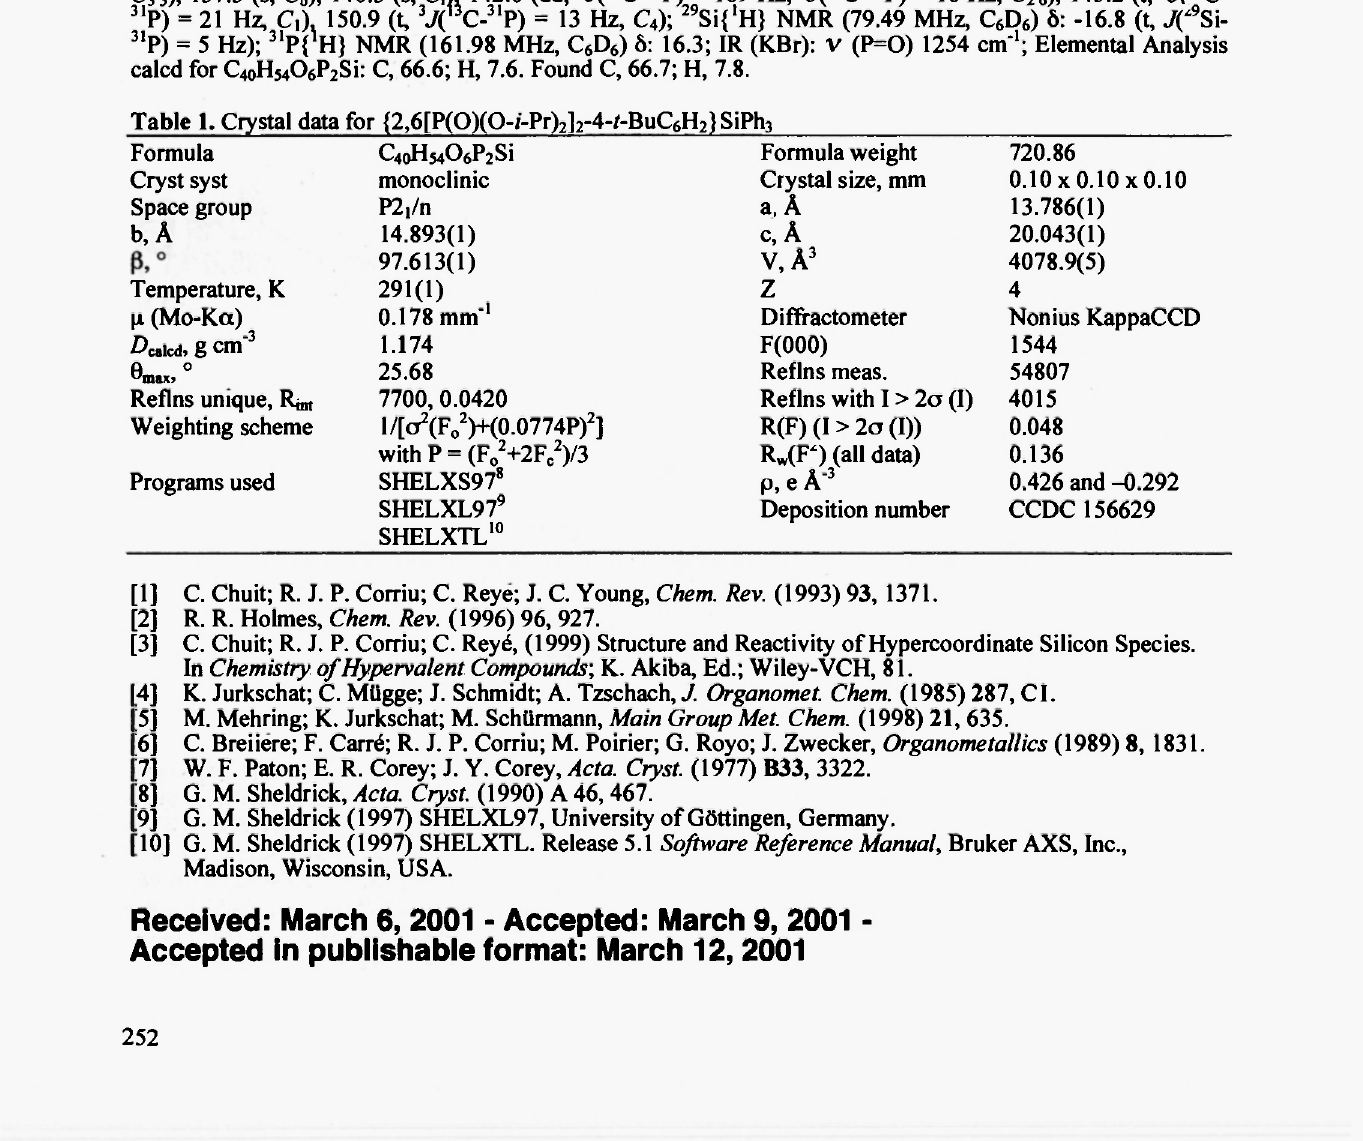
Table 1. Crystal data for {2 ,6rP (0)(Q-/-Pr)